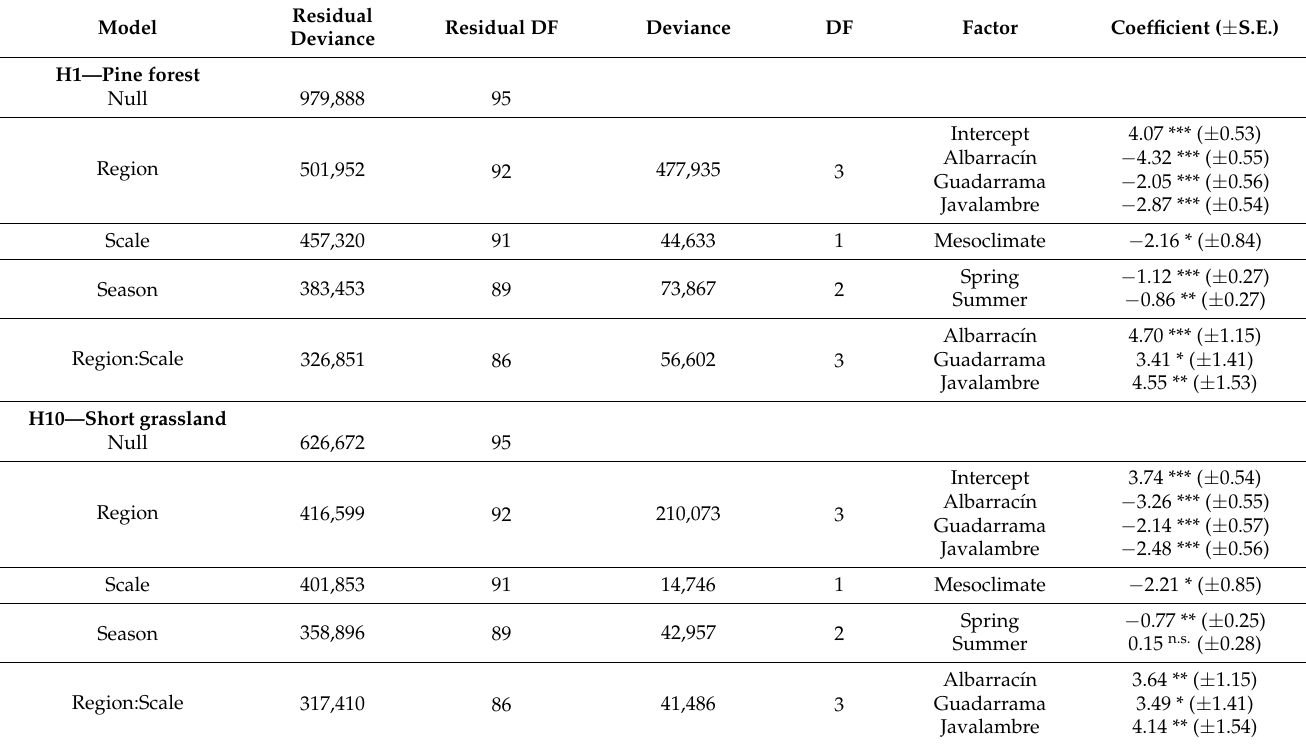
Table 1. Generalized linear models for the proportion of analogous monthly maximum tempera- tures between 1980-89 and 2010-19. Reference categories are Region—Gredos; Scale—Microclimate; Season—Autumn/Winter. The best model was selected based on a quasibinomial error term us- ing quasi Akaike information criterion (QAIC). For H10, QAIC of null model = 166.49, QAIC of model shown = 104.40, QAIC of next-best model = 105.50 (including an additional Region:Season interaction). For H1, QAIC of null model = 121.7, QAIC of model shown = 103.6, QAIC of